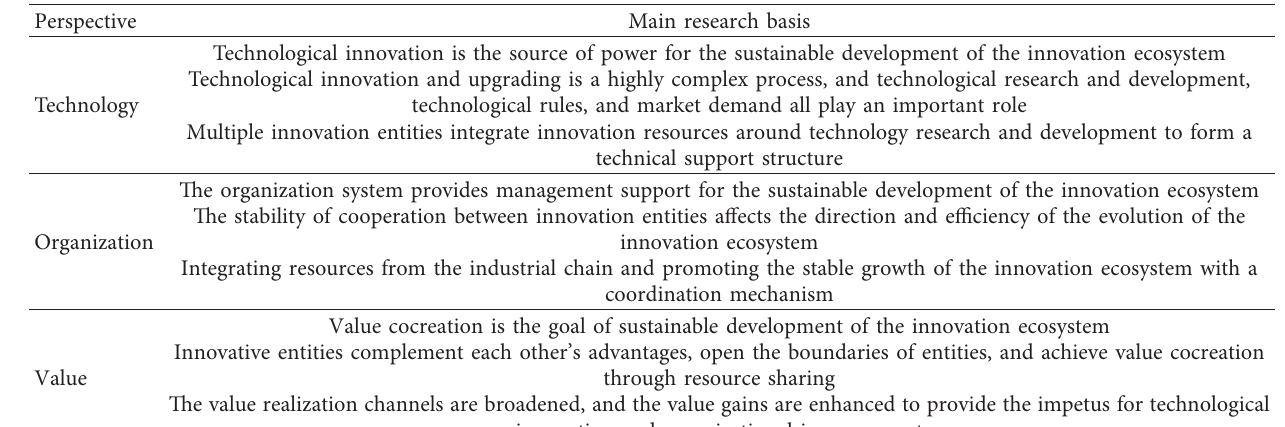
Table 1: Research basis from different perspectives.